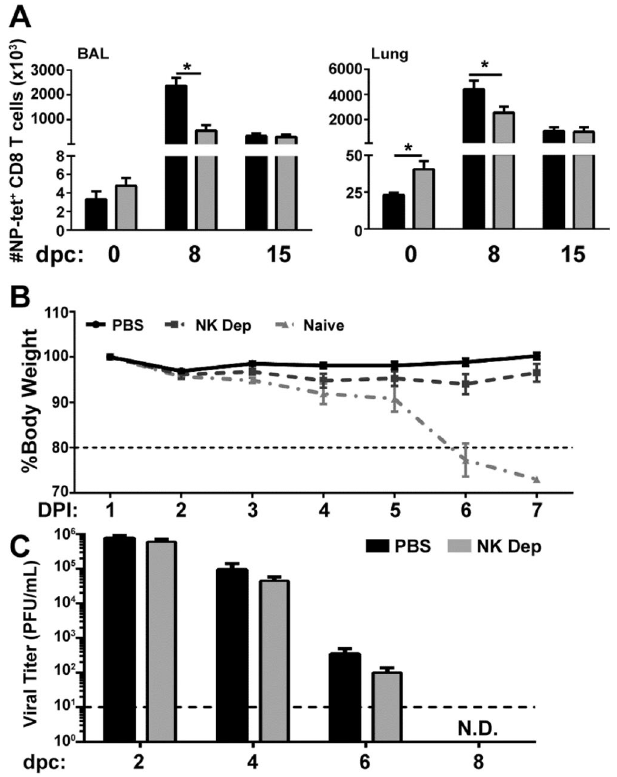
Figure 4. NK depleted animals are equally protected from heterosubtypic challenge by a numerically smaller CD8 + recall response compared to NK sufficient animals. C57BL/6 mice were infected with 10 3 PFU x31 and administered anti-NK depleting antibody on −1, 1, 3 dpi to develop x31 immune mice. ( A ) The x31 immune mice were subsequently challenged with 10 5 PFU PR8 50 dpi. The total number of CD44 hi NP-tet + CD8 + cells ± SEM recovered from the BAL (left) and lung (right) of NK sufficient (black) and NK depleted (grey) mice was determined at 0 (45 dpi), 8, and 15 dpc. ( B ) The percent of body weight lost ± SEM by x31 immune mice generated in the presence (solid black) or absence (dashed, dark grey) of NK cells after a 10 5 PFU PR8 challenge was compared to naïve mice (dash-dot, light grey) after a primary 500 PFU PR8 infection. Horizontal dashed line represents weight loss of 20%; the humane endpoint of 30% was reached by naïve controls on 7dpc. ( C ) The viral titer of lung homogenate recovered from NK sufficient (black) or depleted (grey) immune animals was measured 2, 4, 6 and 8 dpc (N.D. = not detectable). Horizontal dashed line represents the limit of assay detection. Graphs represent pooled data from 2 independent experiments using n = 5 mice/group/time point (total of 10 mice per group/time point). *p < 0.05; unpaired Student’s t-test with Holm-Sidak multiple comparisons